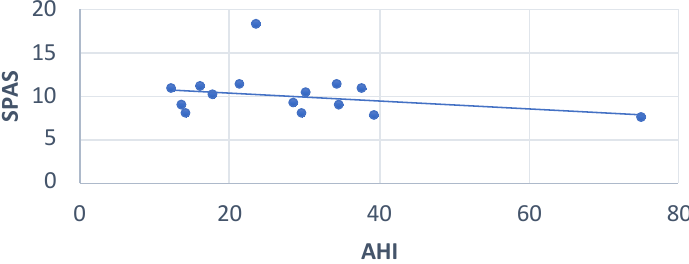
Figure 4. Scatter plot defining the correlation between AHI and PAS. r = − 0.24.